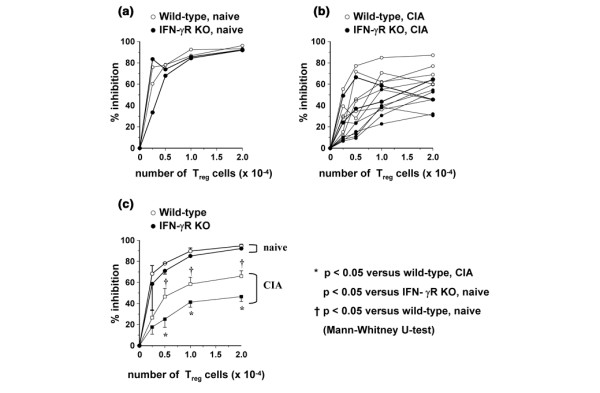
Suppressive capacity of CD4+CD25+ cells is decreased more in immunized IFN-γR KO than in wild-type mice. (a, b) Treg cells, Teff cells and accessory cells (ACs) were isolated from lymph nodes and spleen of naive (a) IFN-γR KO and wild-type DBA/1 mice or from IFN-γR KO and wild-type DBA/1 mice 21 days after immunisation with collagen type II in complete Freund's adjuvant (b). In each case, a group of seven to nine mice was used. CD4+CD25- Teff cells (5 × 104) were incubated with anti-CD3 antibody in the presence of ACs and the indicated number of CD4+CD25+ Treg cells. The percentage inhibition (100 × (Radioactivity in condition without Treg cells – Radioactivity in condition with Treg cells)/Radioactivity in condition without Treg cells) of the proliferation of Teff cells (CD4+CD25-) by increasing numbers of CD4+CD25+ Treg cells is shown. Two and seven independent experiments are shown in (a) and (b), respectively. Each result is the mean of two cups. (c) The means of the two (naive mice) or seven (immunised mice) independent experiments shown in (a) and (b). Error bars indicate SEM.